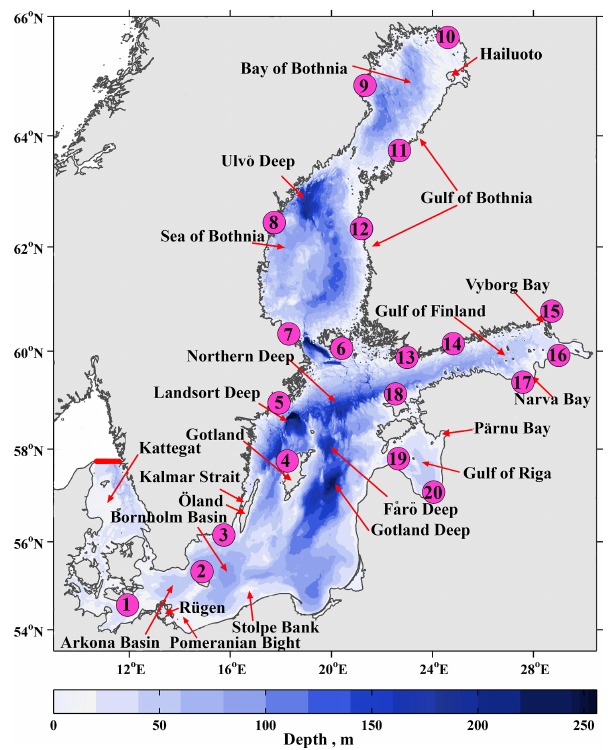
Figure 1. Bathymetry and locations of tide gauge stations used for model validation. The liquid boundary of the modelled area in the Kattegat Strait is indicated by bold red line. The map is created using the Baltic Sea Bathymetry Database (BSBD) http://data.bshc. pro/ (last access: 5 April